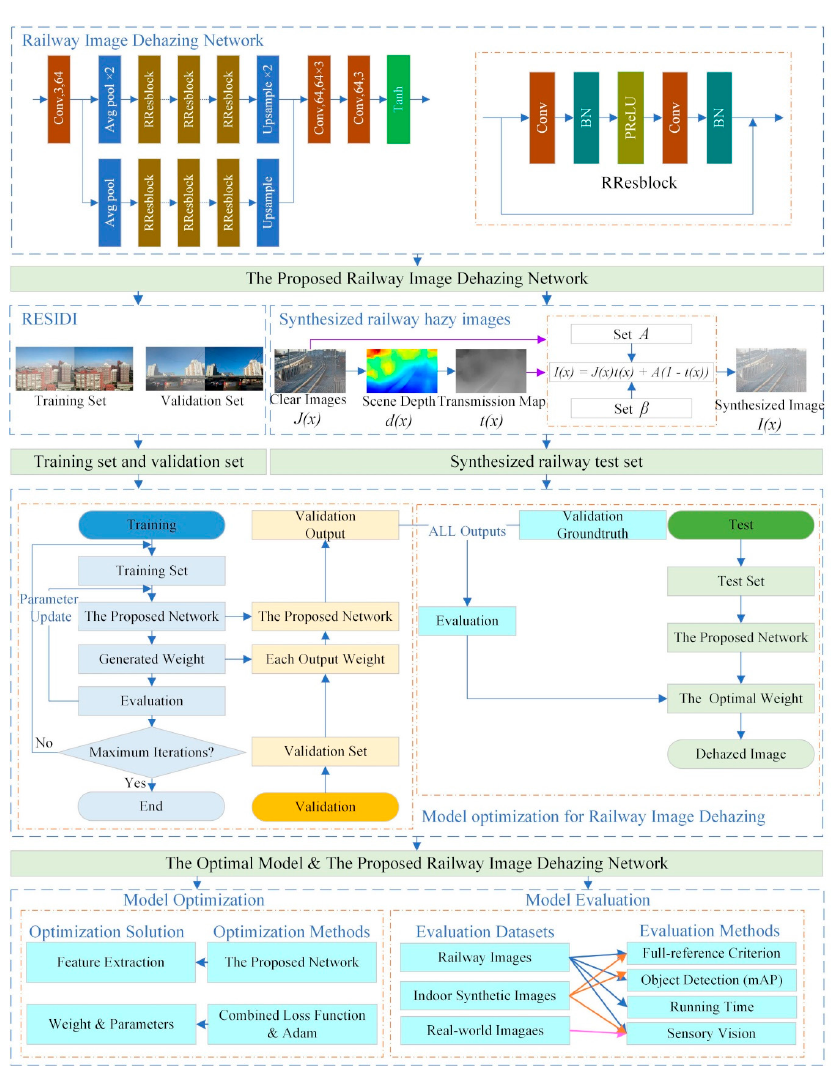
Figure 1. The overall scheme of haze removal for railway images using residual CNNs.